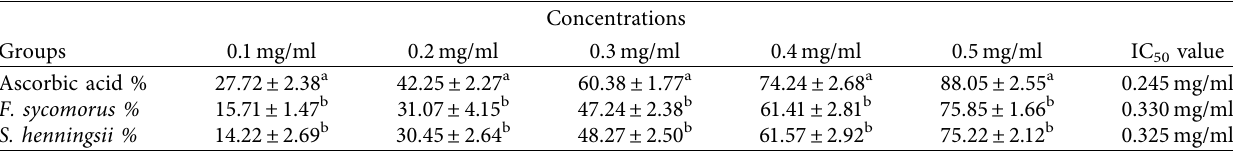
Values are expressed as mean ± SEM for three replicates. Column means with the same superscript were not signifcantly diferent by ANOVA followed by Tukey’s post hoc test ( p > 0 .